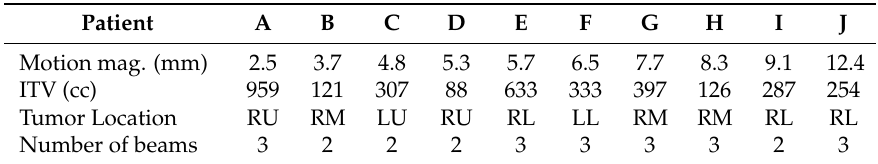
Table 1. Tumor characteristics and number of IMPT beams for the patients included in the study. The first letter R or L in the tumor location acronym stands for right or left, and the second letter U, M or L designates up, middle or lower